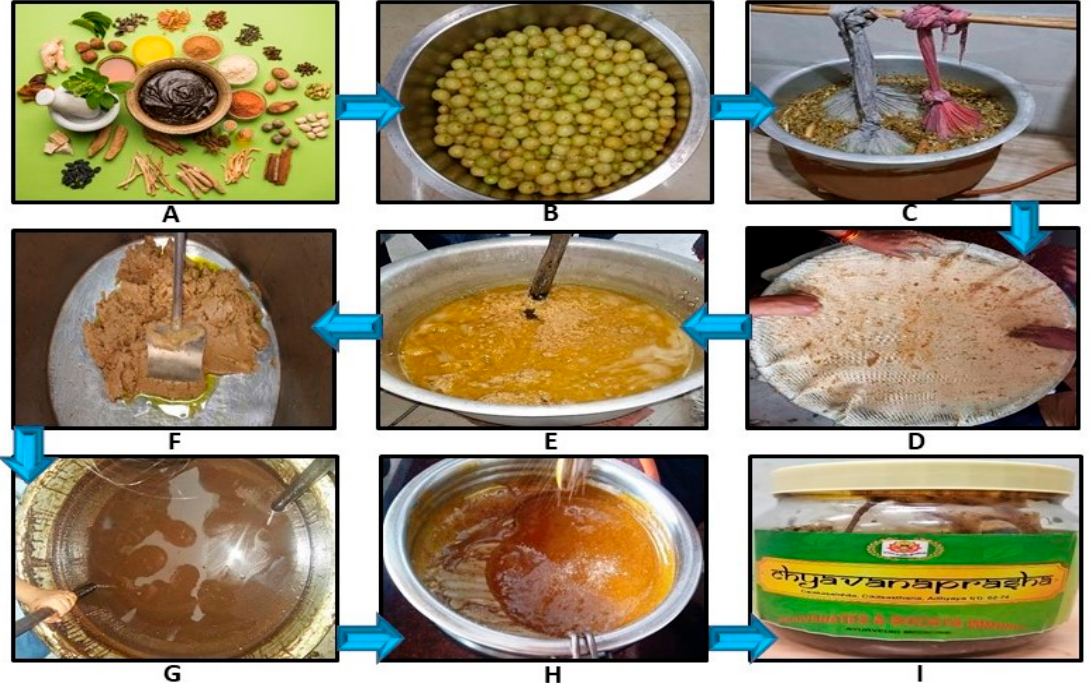
Figure 2. Unit operating process of traditional Chyawnprash preparation. (A) Raw material collection; (B) fresh Amla taken; (C) Amla boiling in pottali suspended in herbal decoction; (D) Amla pulp separated in muslin cloth; (E) Amla pulp frying in ghee and sesame oil; (F) fried until pulp goes brownish-red and the lipids start separating; (G) Pishthi cooked in decoction syrup until the attainment of two strings viscidity; (H) upon cooling, prakshepa herbal powders and honey added and mixed homogeneously; (I) finally, prepared Chyawanprash packed in airtight sterile containers.